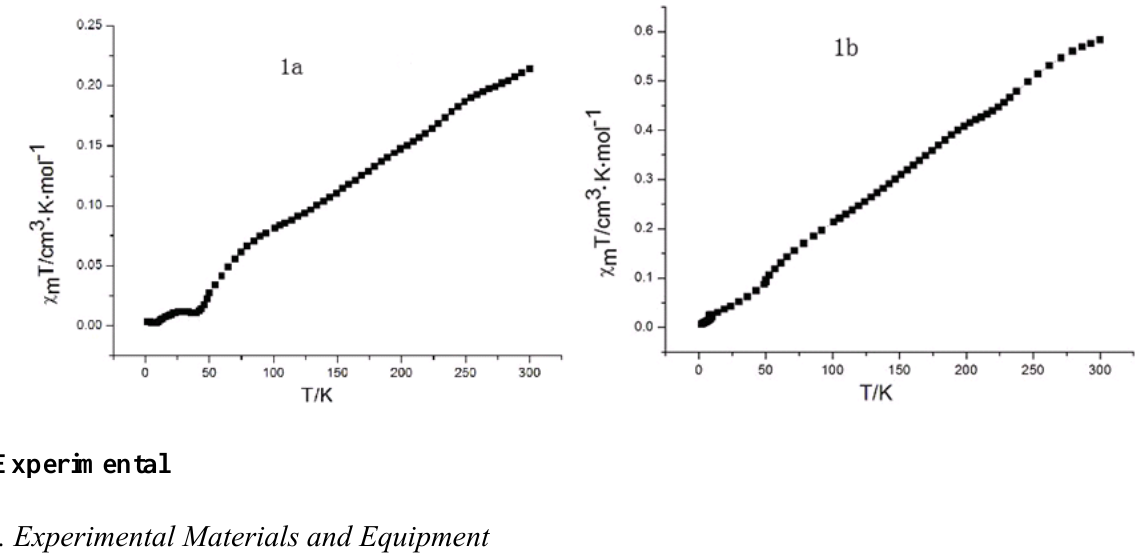
Figure 9. χ m T curves of magnetic measurements for 1a and 1b